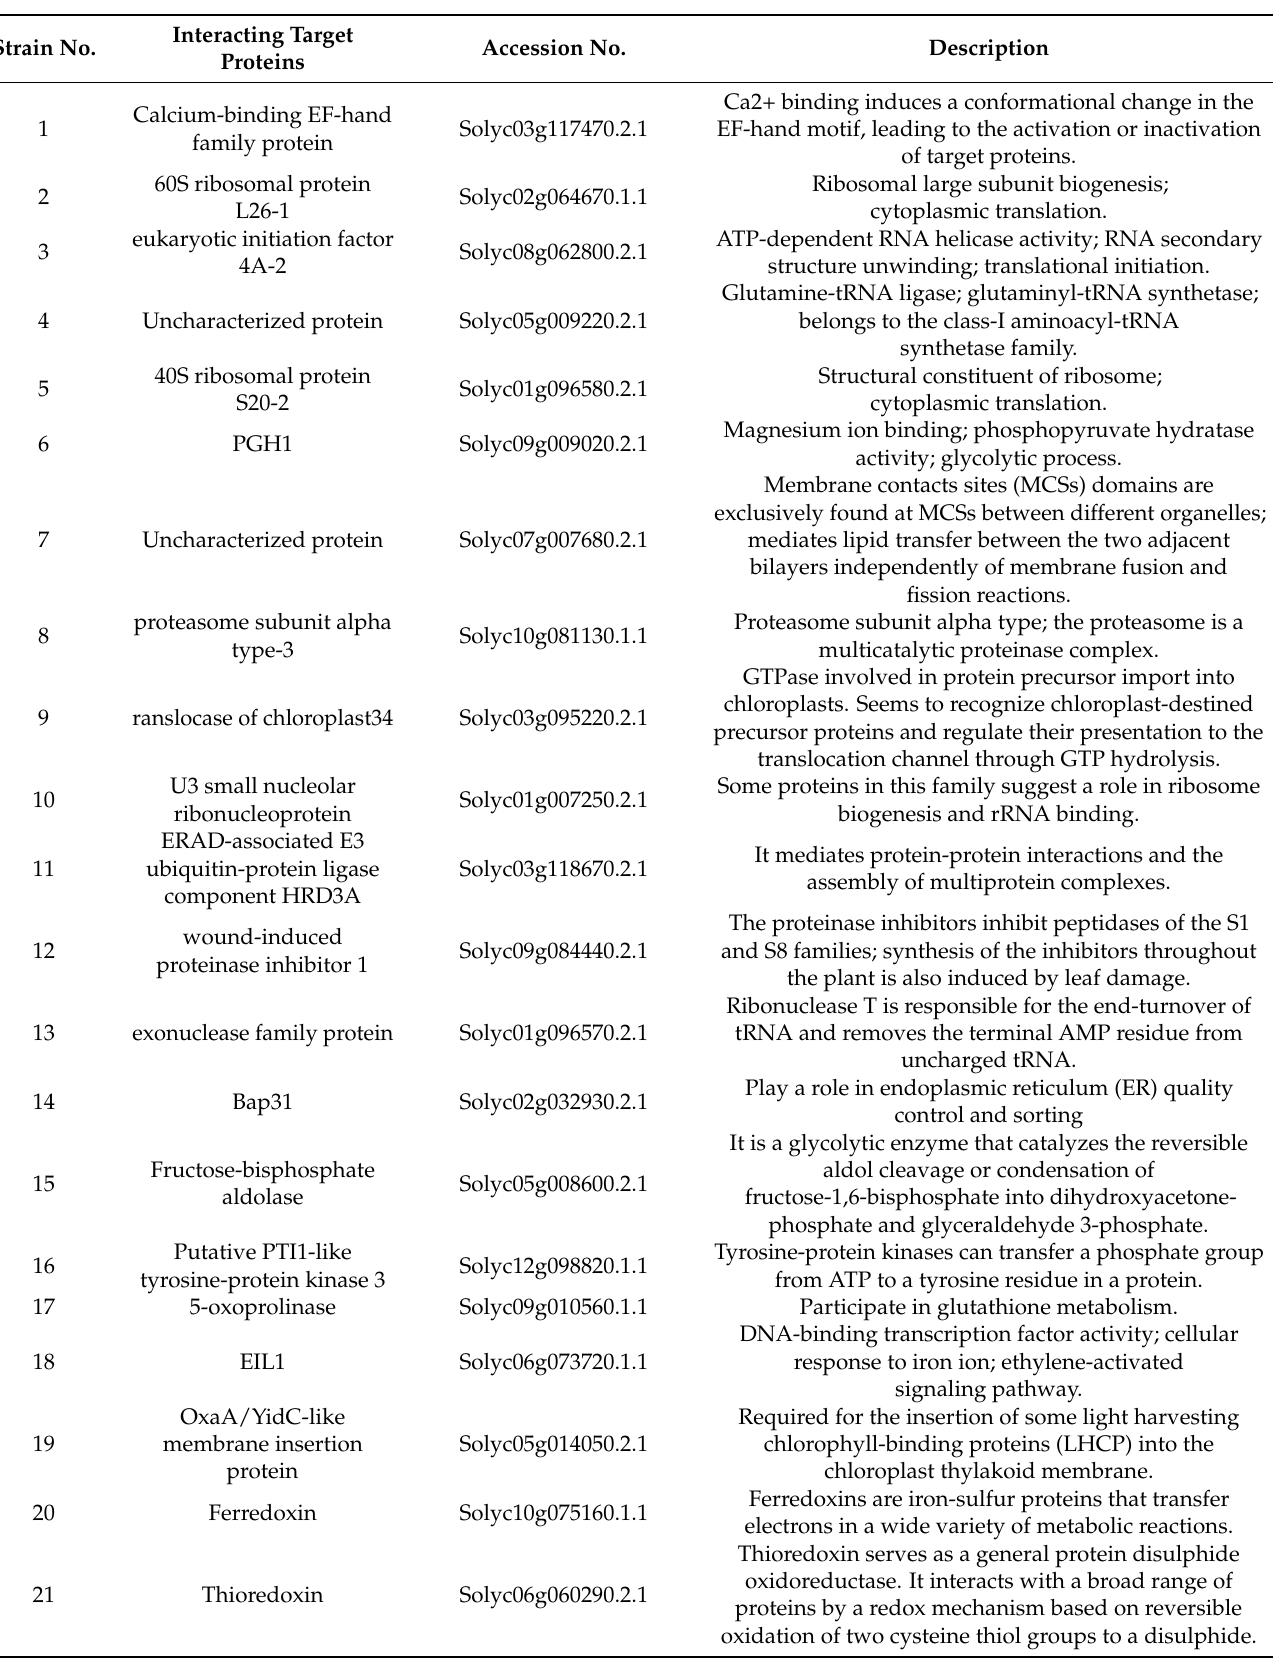
Table 1. Protein interactions of ShROP7 identified from yeast two-hybrid